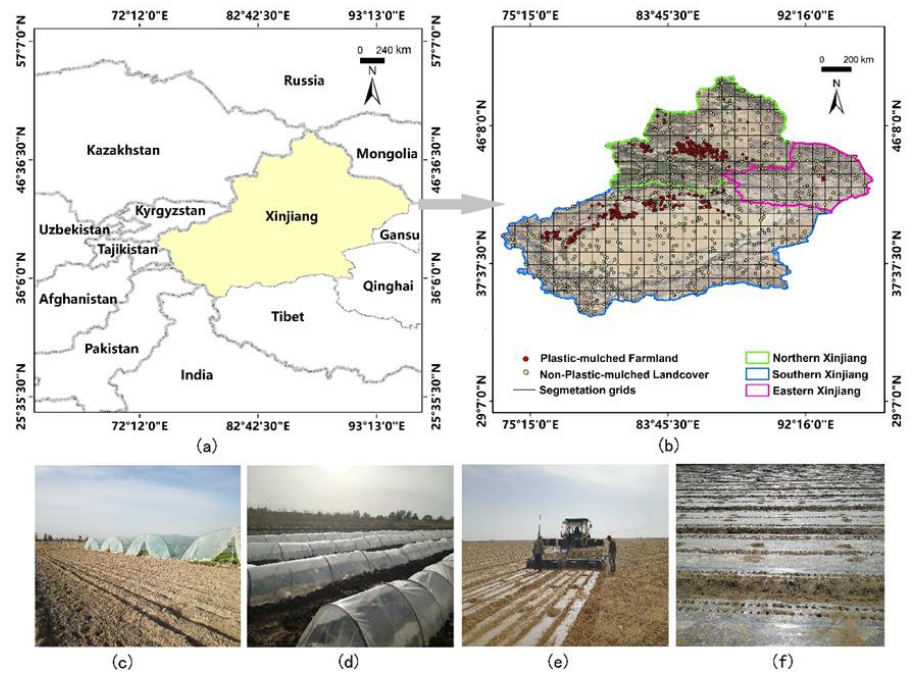
Figure 2. Location of the study area (the imagery displayed on the right panel is a true color mosaic generated on the Google Earth) and the three main types of plasticulture in Xinjiang, China as in the year 2018. ( a ) The location of the study area; ( b ) the spatial distribution of samples points in the study area; ( c ) greenhouses in Mido District, Urumqi (44°4′15′′N, 87°30′19′′E); ( d ) low tunnels in Changji City (44°3′2′′N, 87°21′43′′E); and ( e )( f ) plastic mulch in Changji City (44°13 ’55′′N, 86°37′36′′E).